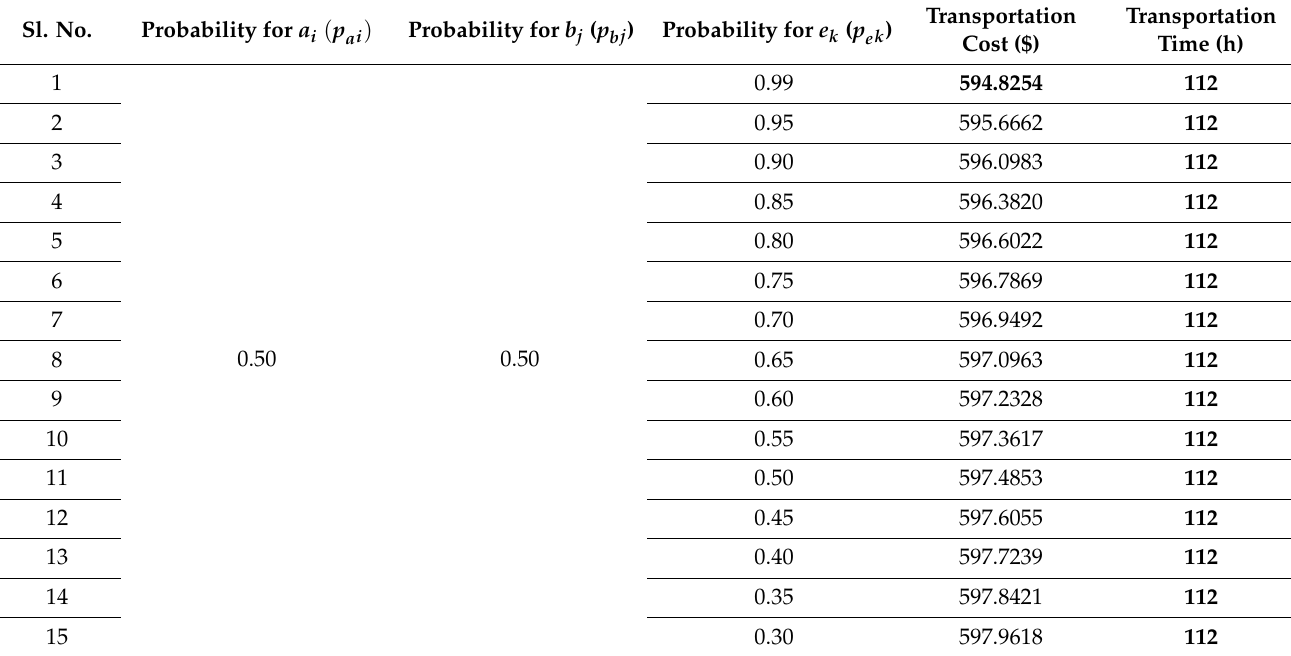
Table 9. Sensitivity analysis with respect to the probability for e k